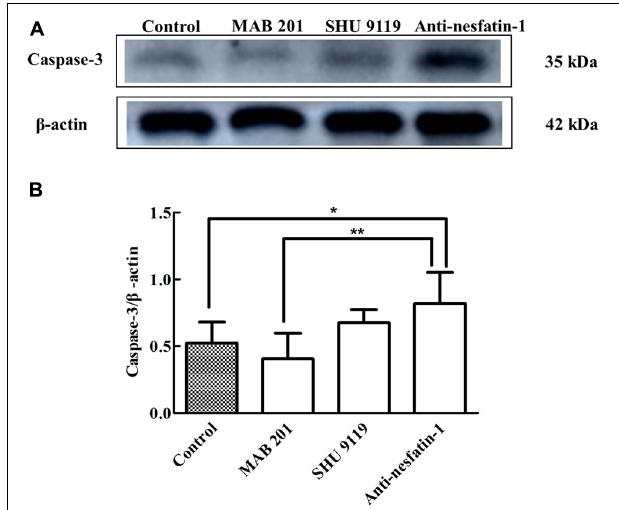
FIGURE 5 | Anti-nesfatin-1 antibody treatment stimulated caspase-3 protein expression in the SNpc ( n = 6). (A) An original image of a Western blot showing the caspase-3 protein levels in control mice and mice treated with MAB 201, SHU 9119, or anti-nesfatin-1 antibody. (B) Statistical analysis of caspase-3 protein levels in the different groups. Each value represents the mean ± SD, n = 6; ** p < 0.005, and * p < 0.05. MAB 201, non-immune anti-mouse IgG antibody; SHU 9119, MC4R receptor inhibitor; SNpc, substantia nigra pars